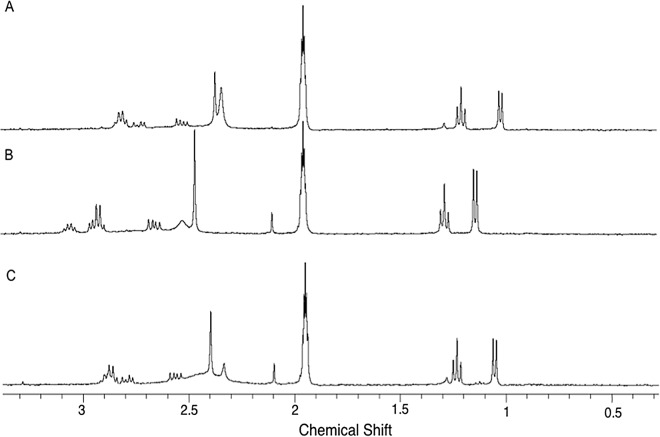
Expanded Spectra 1H HR-MAS NMR of (A) (S)-enantiomer (13.0 mmol.L-1), (B) (R)-enantiomer (13.0 mmol.L-1), and (C) racemic mixture (13.0 mmol.L-1) in the presence of 1 mg of CSP-ID suspended in ACNd3/DEA (100:0.1, v/v).